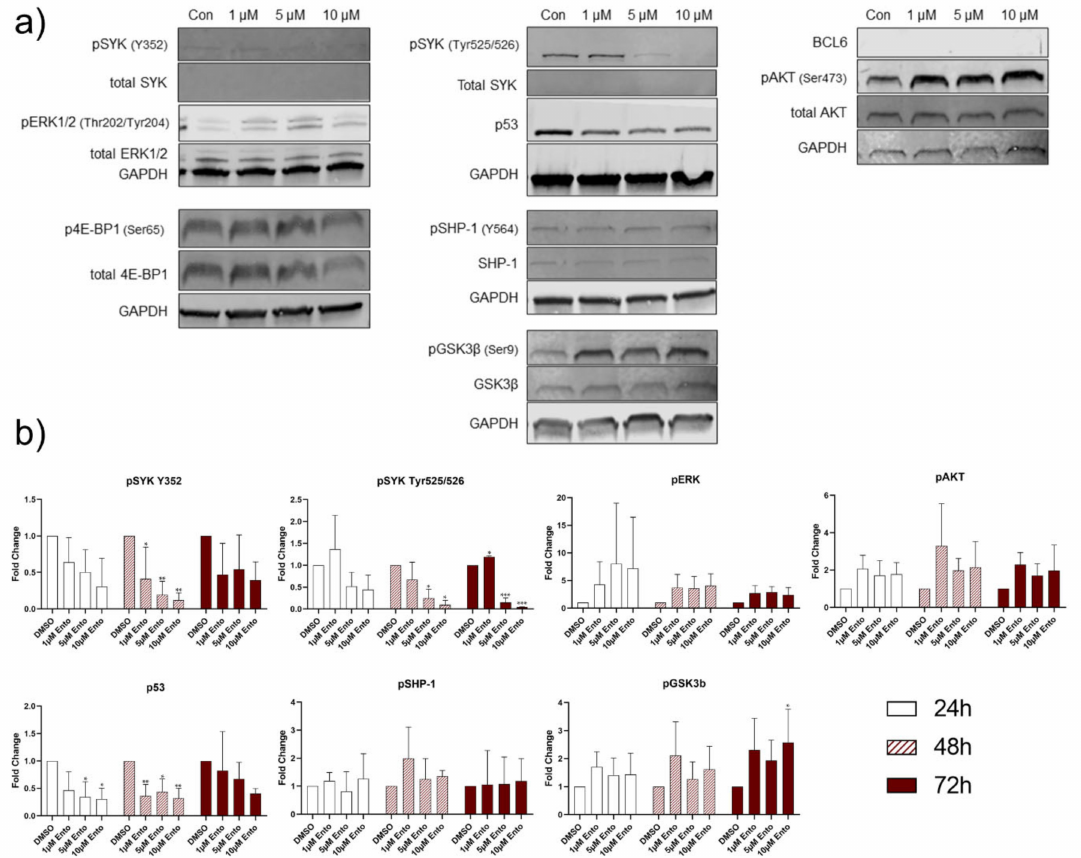
Figure 8. Entospletinib-induced distinct downstream protein modifications in pro-B-ALL SEM. ( a ) Representative Western blot images of SEM cells after 72 h exposure. ( b ) Western blot quantification of key proteins ( ≥ 3 independent Western blots for 24 h, 48 h and 72 h time points). Data are presented as the mean ± SD. Statistical significance was calculated by one-way ANOVA followed by Dunnett’s test as a post-hoc analysis and displayed as * p < 0.033, ** p < 0.002, *** p < 0.001 versus the control group ( n ≥